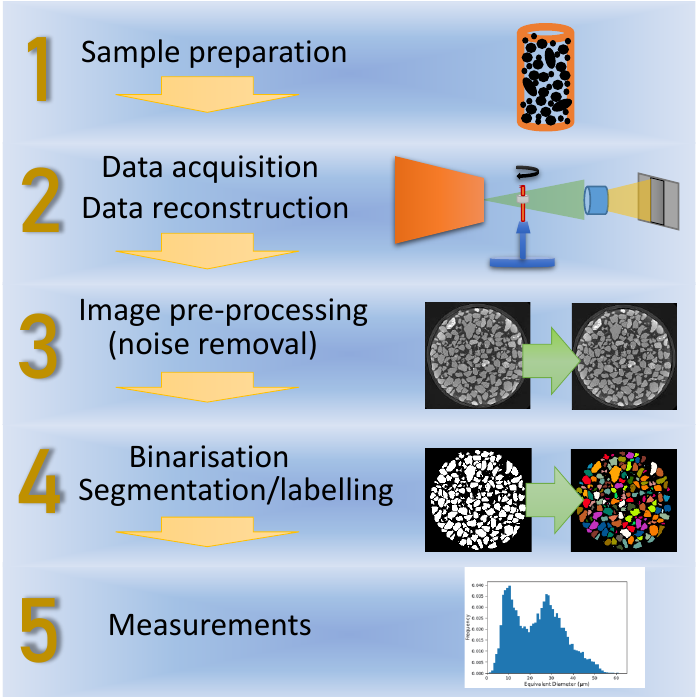
Figure 4. Generalised scanning and analysis workflow for particle characterisation with X-ray CT. After sample preparation (Section 2.1), the X-ray CT data are acquired and reconstructed. The resulting greyscale data are usually pre-processed, for example, for noise smoothing, before further processing. To enable quantification, each particle must be segmented (or labelled) individually (Section 2.4), which typically follows a general binarisation step that separates all particles from the surrounding medium. Once segmented, individual particle size and shape parameters can be determined (Section